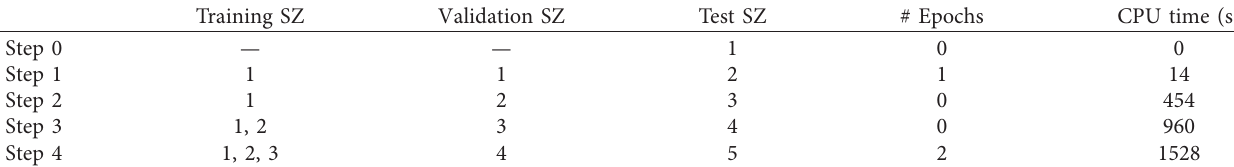
Figure 7: Results of the cross-patient seizure detection procedure in terms of Specificity (a) and Sensitivity (b), starting from the seizure detection model of patient #9: trend of Specificity and Sensitivity during the temporal occurrence of the 8 seizures of the patient #6. Blue line: trend on the training set; red line: trend on the validation set; green squares: results on the test Table 7: Steps of the cross-patient seizure detection process for patient #5.